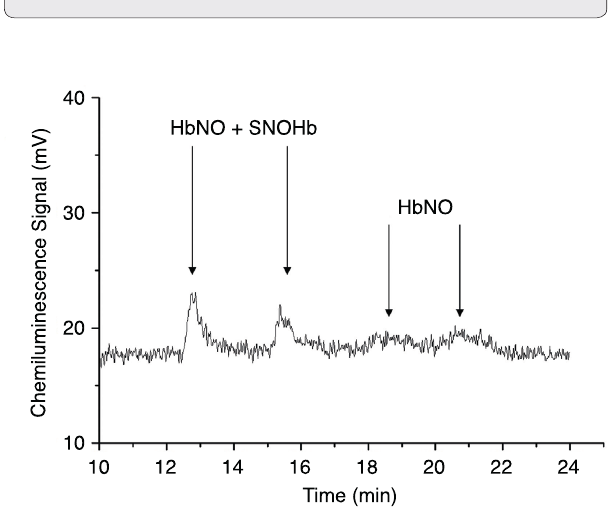
Figure 5. SNOHb levels in fresh blood (assay performed in the first hour after venisection). Gas-phase chemiluminescence signals used to determine SNOHb concentration. The peaks from two samples in the first 20 minutes of storage are shown; SNOHb concentration is ascertained by subtracting the HbNO peak from the composite of SNOHb plus HbNO after treatment with HgCl acid sulfanilamide. The values of SNOHb, near the sensitivity of the method, are less than 30nM, while HbNO is barely detectable. Neither peak was detected after 1hr of